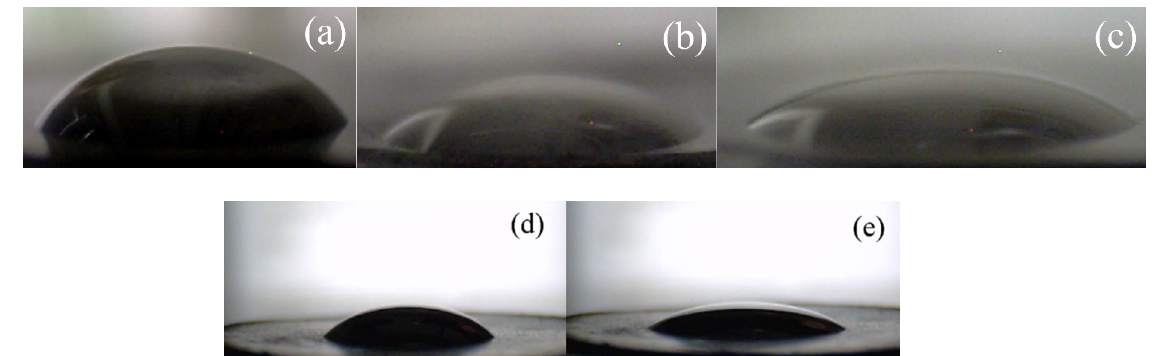
Figure 5. Contact angle investigations using sessile drop method on: ( a ) the neat GO, ( b ) GO-PMMA, ( c ) GO-PBMA, ( d ) GO-PGMA, ( e ) GO-PHEMATMS.